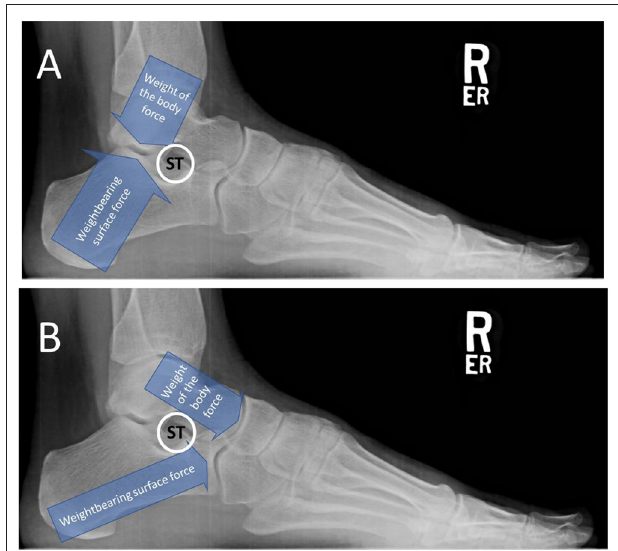
FIGURE 1 | Weightbearing lateral foot radiograph of a foot in resting stance position showing normal talotarsal joint forces. (A) Forces acting posterior to the sinus tarsi at heel strike. The sinus tarsi is labeled as ST. (B) Forces acting anterior/distal to the sinus tarsi as the plantar surface of the foot makes contact with the weightbearing surface. Sinus tarsi should remain